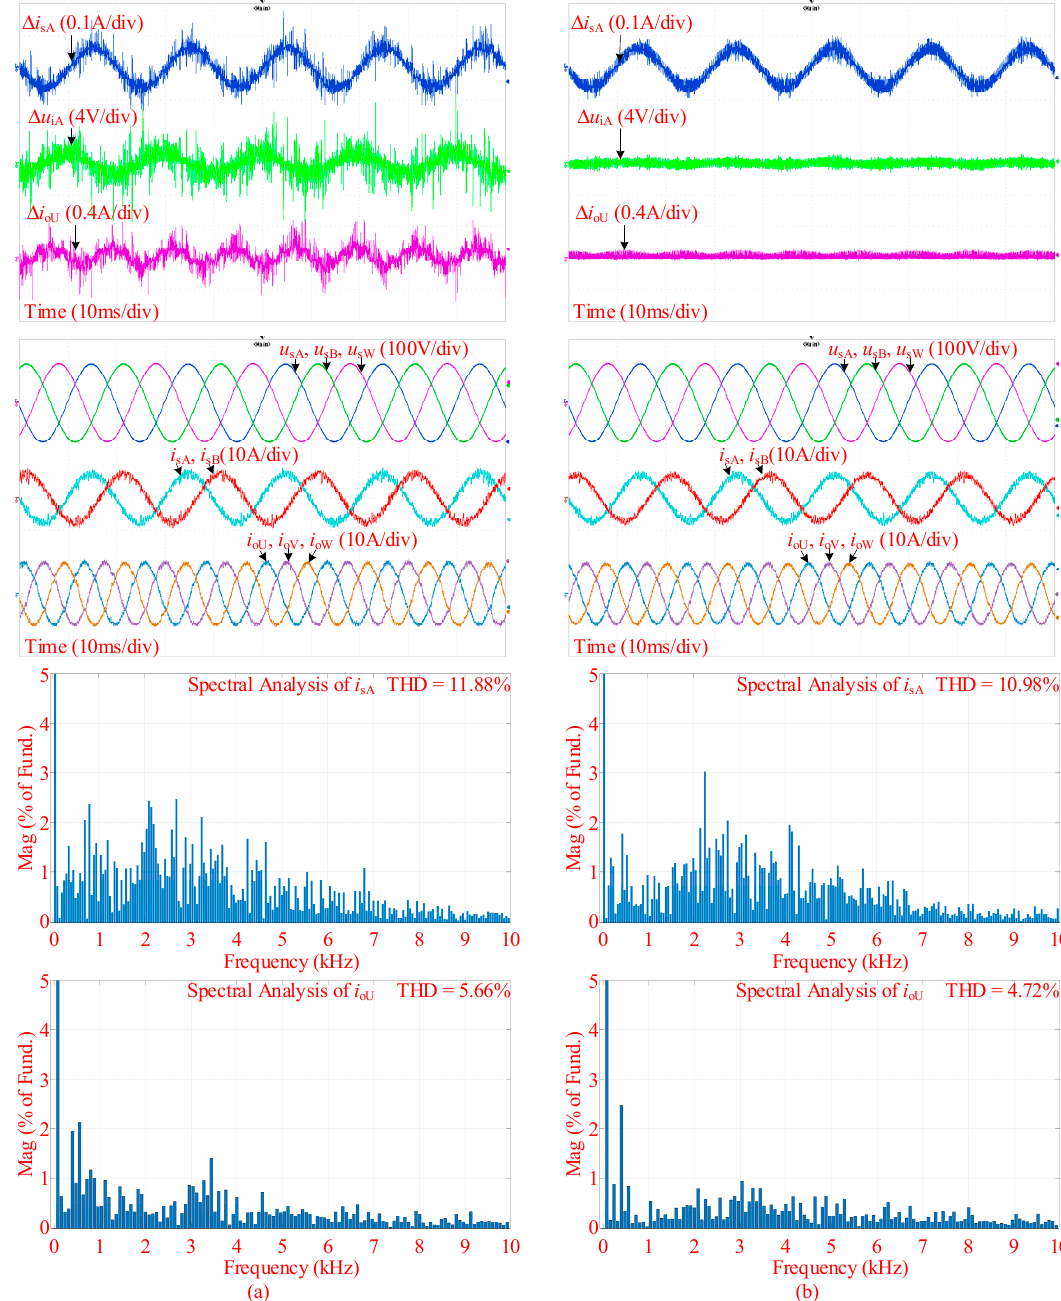
Figure 7. Experimental results of Case 2: ( a ) with the conventional MPC and ( b ) with the improved MPC. The sampling time is increased to 40 μ s.